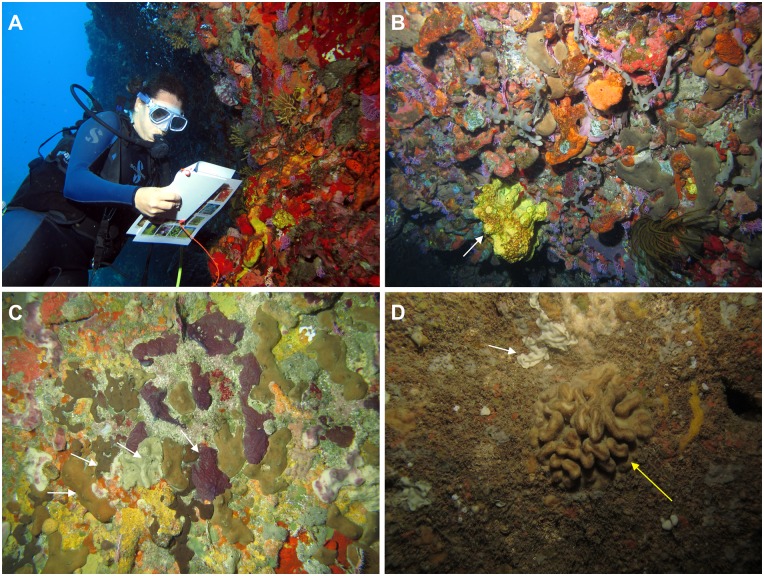
In situ photographs of cave community in Martinique.A) A participant of the Sponge Training Course at the entrance of the Diamond Rock Tunnel; B) This semi-dark community dominated by sponges, with the new spherical Aiolochroia (white arrow); C) With reduced light, the species diversity decreases, but sponges, especially Homoscleromorpha (white arrows), are still dominant (Diamond Rock tunnel); D) In dark conditions, most sponge species are encrusting forms, such as the new Plakina arletensis (white arrow), but in some places big specimens of the lithistid Aciculites sp. (yellow arrow) can be found (Grotte Chauve-Souris, Anses d’Arlet). All pictures by T. Pérez.